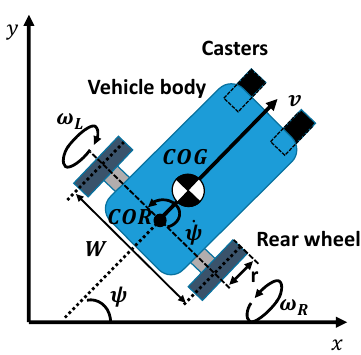
Figure 3. Top view of the proposed EW model. Table 1. Parameters of the EW model.